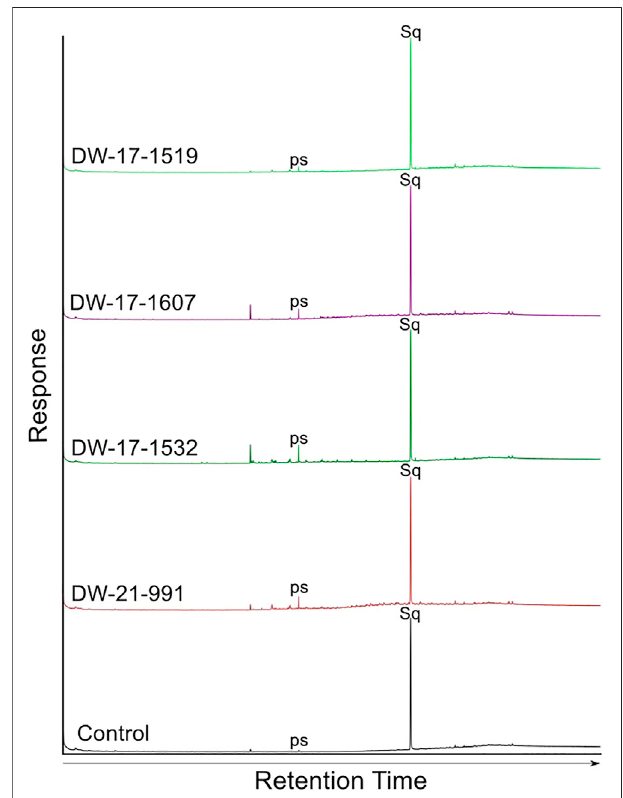
FIGURE 3 | GC-MS results of hydrocarbon fractions from extract obtained for sandstone samples of the dry wells serving as background. The samples are from wells 21/17-1, 21/17-2 and 21/21-1. A control sample is also included to ensure accurate interpretation of